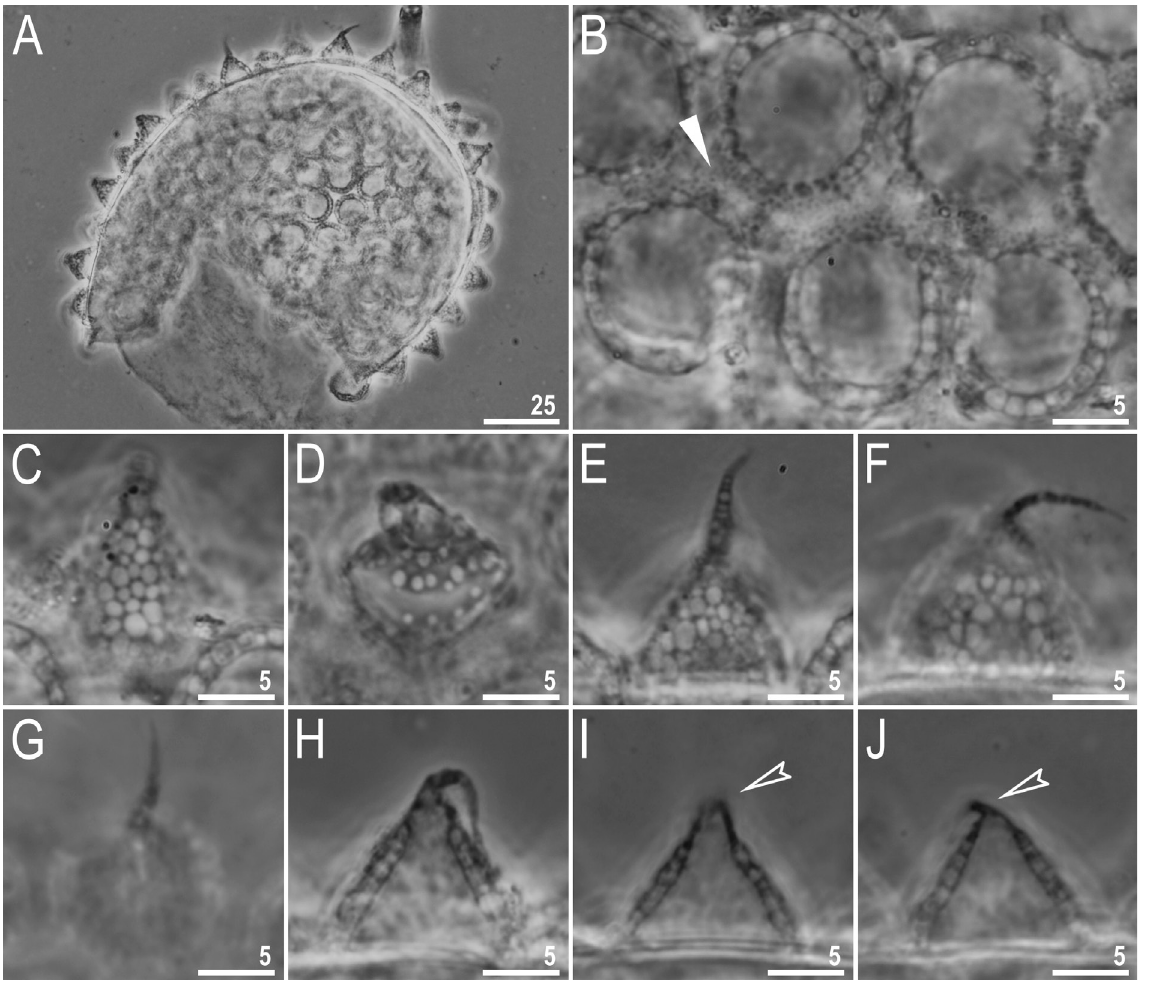
Fig. 21. Tenuibiotus voronkovi (Tumanov, 2007) Egg chorion morphology seen in PCM. A . Midsection under 400× magnification. B . Surface between processes under 1000× magnification. C – J . Details of egg processes under 1000× magnification. Filled flat arrowhead indicates thickenings/striae/sculpture which are visible as dark dots on the surface between processes and indented empty arrowheads indicate broken apices of the egg processes. Scale bars in